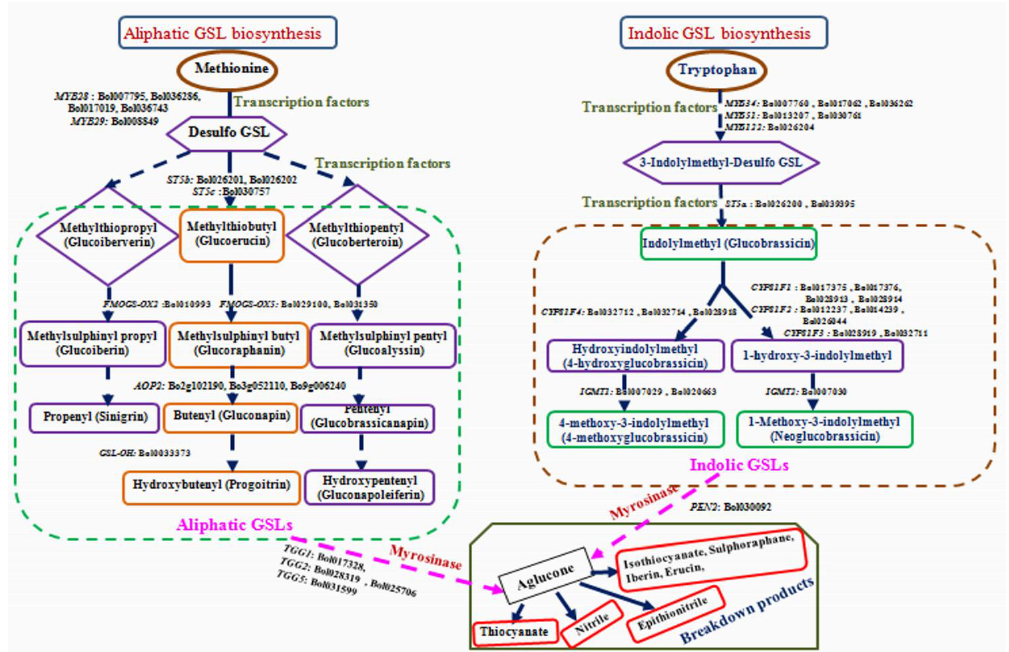
Figure 2. The glucosinolate pathway showing the transcription factors, glucosinolate (GSL) biosynthesis and breakdown related genes indicated aliphatic and indolic GSL biosynthesis pathways adopted from previous studies [33,35,37]. A total of 43 genes were selected (15 and 23 genes from aliphatic and indolic GSL biosynthesis pathway and 5 genes from GSL breakdown, respectively). Blue color indicates the genes, which were highly expressed in the resistant line and red color indicates the genes which were highly expressed in susceptible cabbage line after infection with X. campestris pv. campestris race 4. Bold green color number in bracket indicates 1 and 3 days after